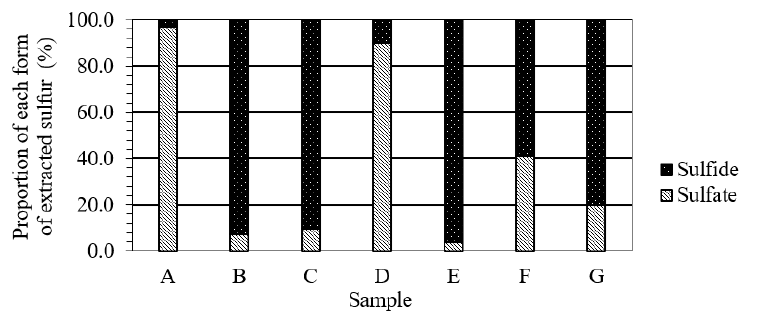
Figure 7. Proportion of sulfide and sulfate in all samples calculated based on sequential acid extraction results: calculated via the ratio of the amount of sulfur in the HCl and HNO 3 extraction stages to total sulfur.